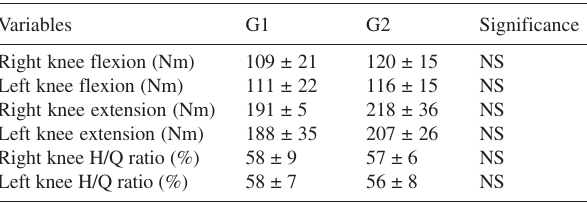
Table 2 - Isokinetic strength comparison between the athletes with and without anterior cruciate ligament laxity Variables G1 G2 Significance Right knee flexion (Nm) 109 ± 21 120 ±